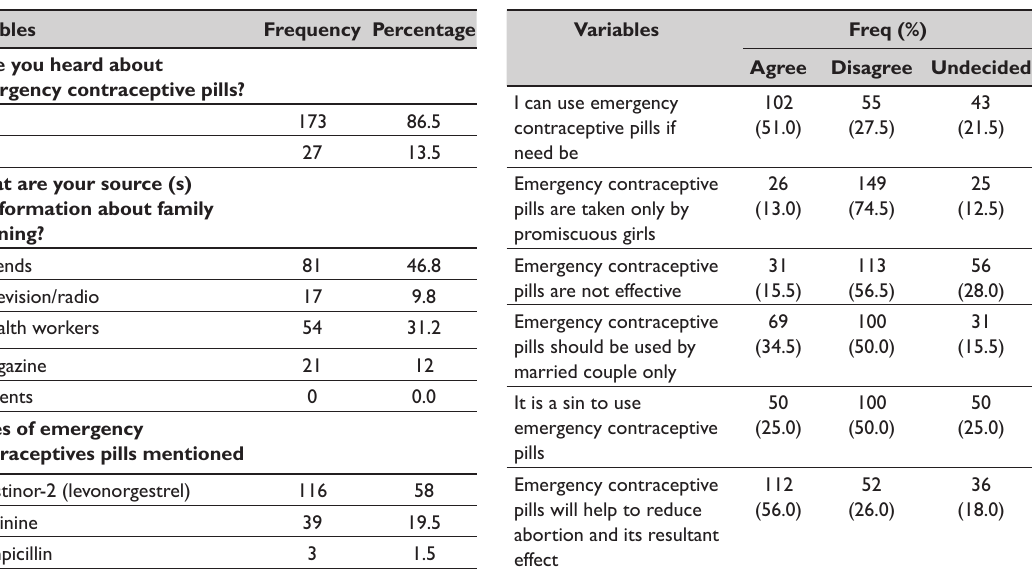
Table 2. Respondents’ knowledge of emergency Table 3. Attitude towards emergency